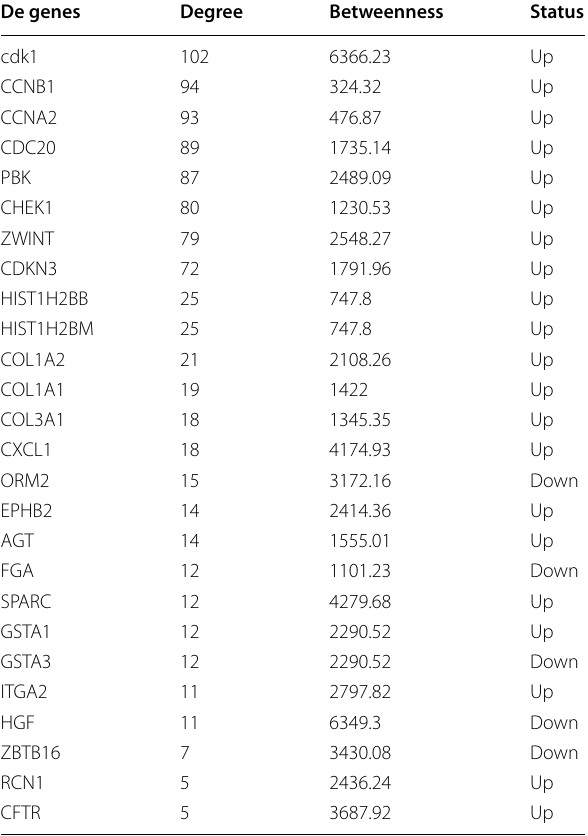
Table 1 The network hub genes. DEGs were sorted based on the highest degree. Status column exhibits whether a gene is upregulated or downregulated in the